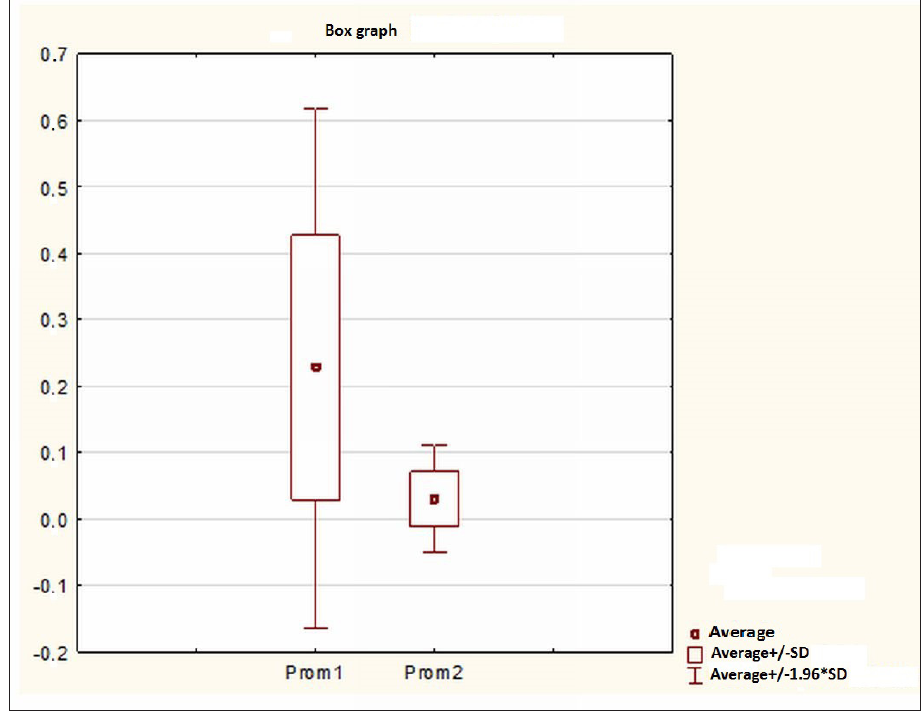
Fig. 3. Statistically significant difference between sVEP (Prom1, logMAR) and Snellen (Prom2, logMAR) methods in sample